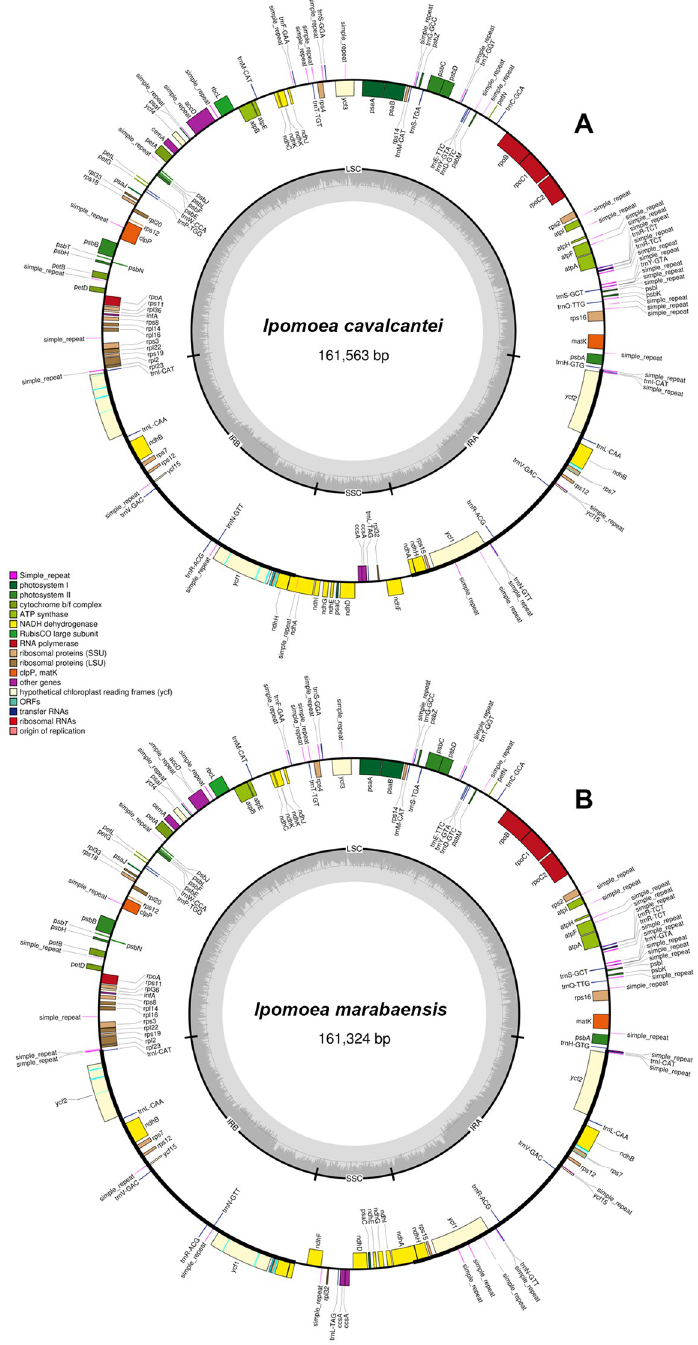
Fig 2. Circular map of the plastomes of Ipomoea cavalcantei (A) and I . marabaensis (B), showing the typical quadripartite structure indicated in the inner circle (IRB, LSC, IRA and SSC). The gene categories are shown in colored boxes and simple repeats sites are indicated in